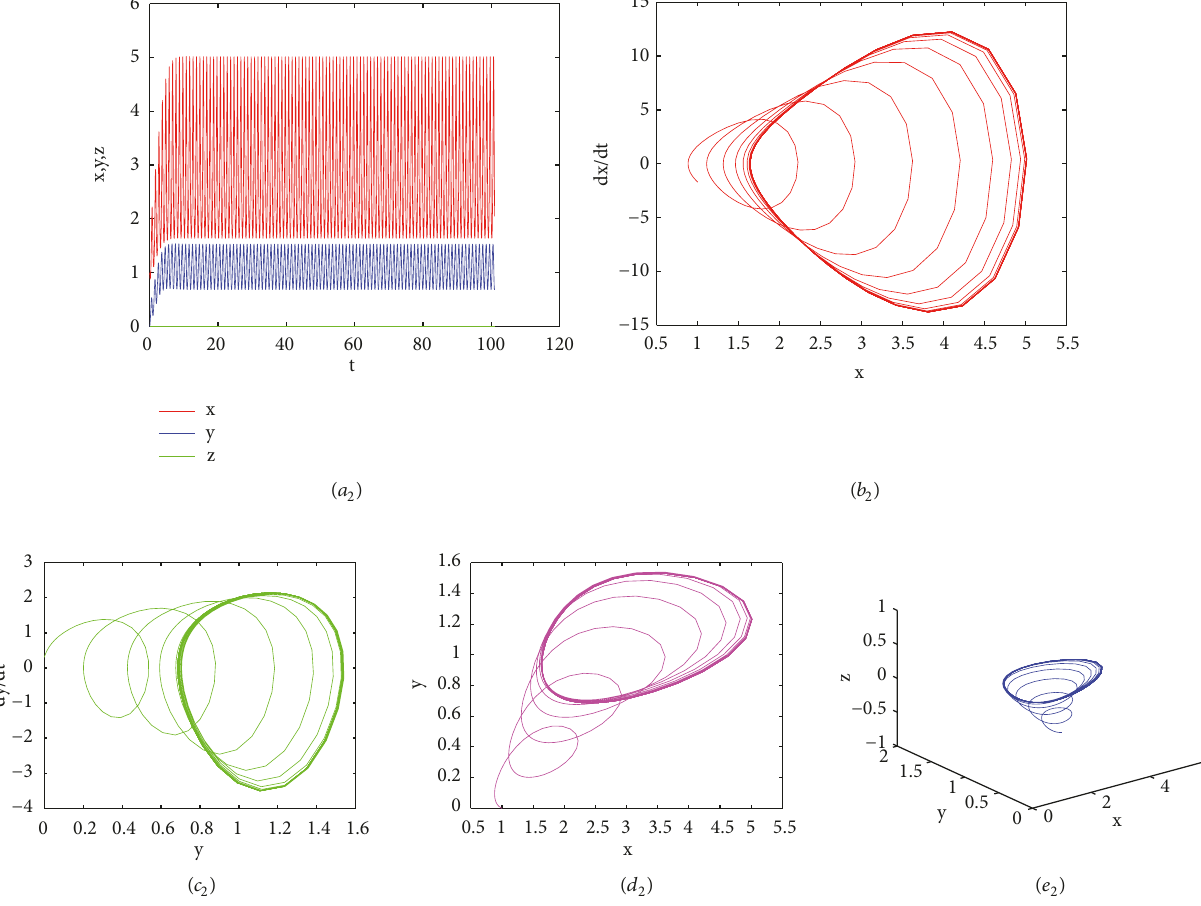
Figure 11: The results of Experiment 6: (𝑎 2 ) time series plot of 𝑥,𝑦, 𝑧 ; (𝑏 2 ) phase diagram of 𝑥 ; (𝑐 2 ) phase diagram of 𝑦 ; (𝑑 2 ) projected on the (𝑥,𝑦) -plane; (𝑒 ) on the three-dimensional space. 2